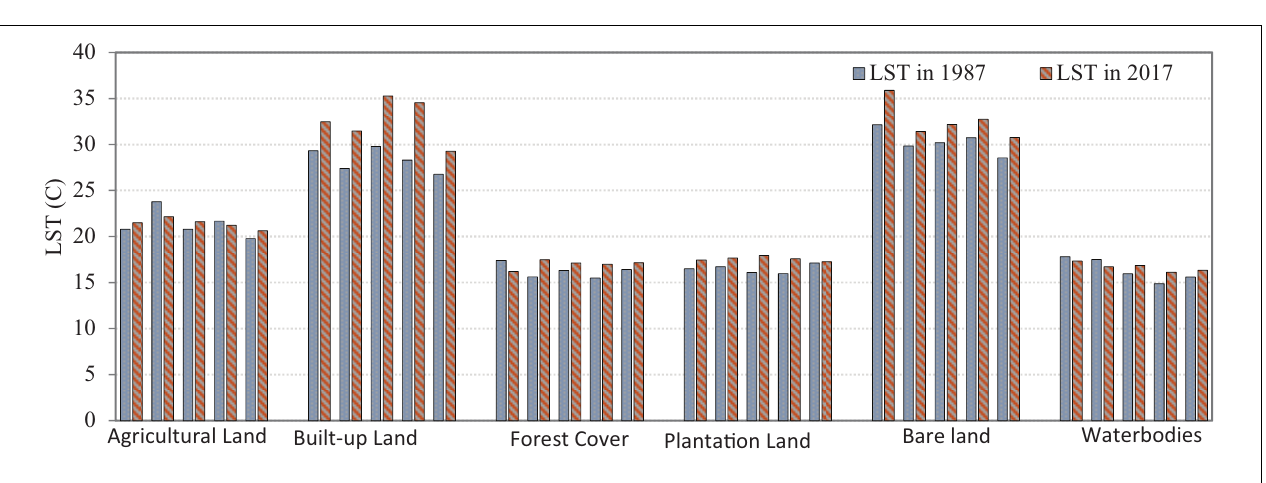
FIGURE 4 | LST in different LULC categories